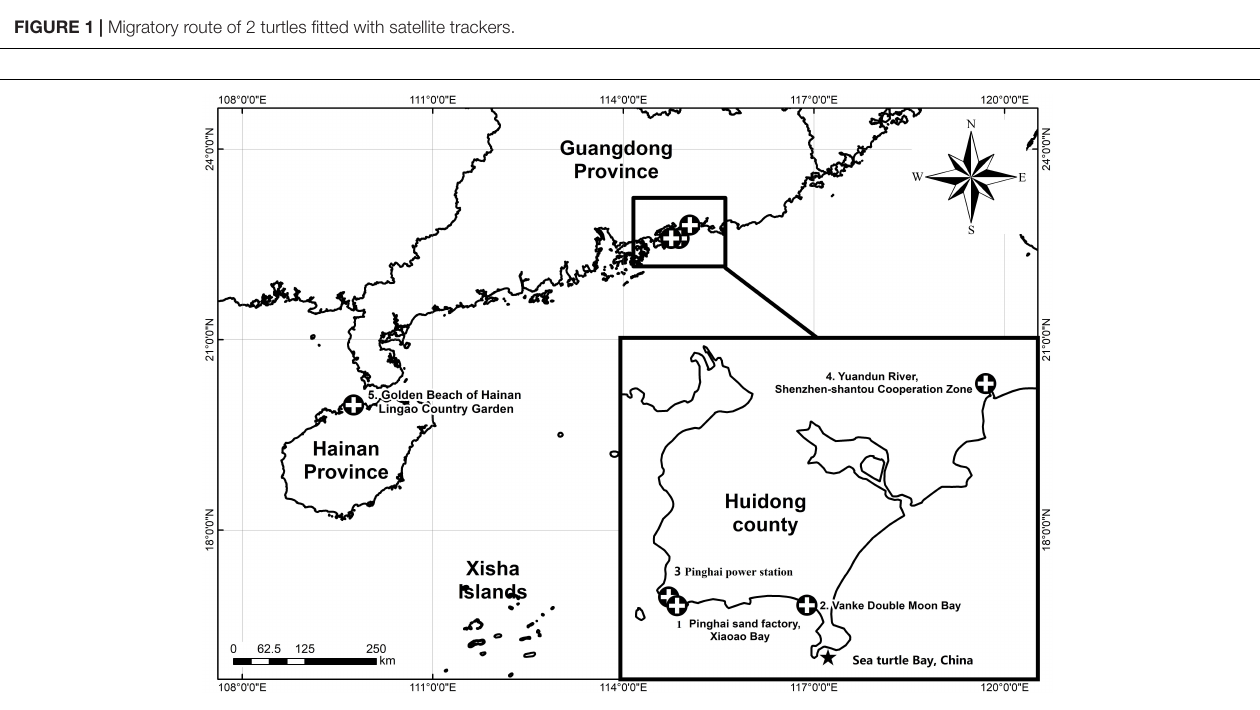
FIGURE 1 | Migratory route of 2 turtles fitted with satellite trackers.